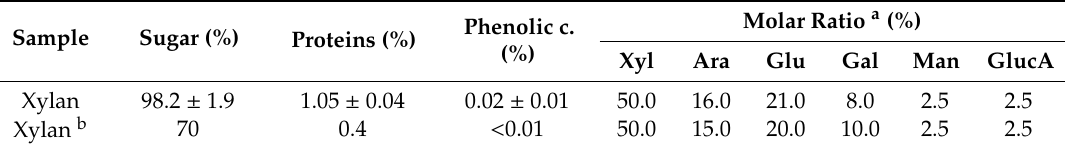
Table 1. Chemical composition of xylan from corn